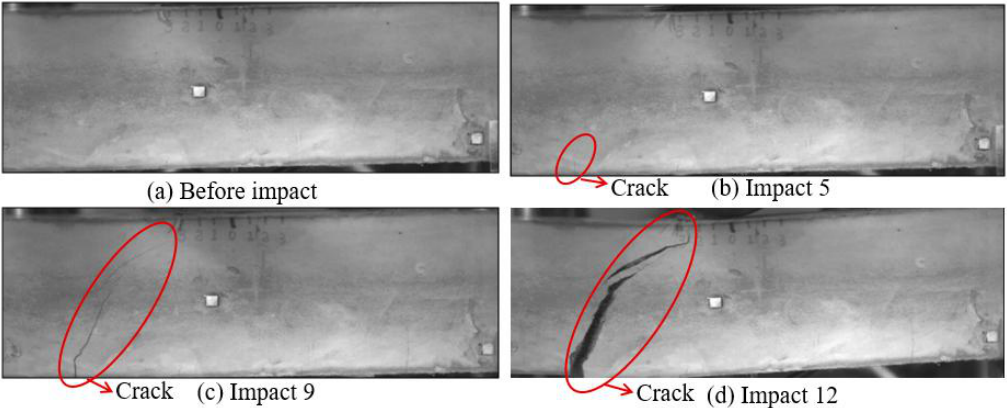
Figure 10 . Results of crack detection in PVA-ECC-1 with high-speed video.